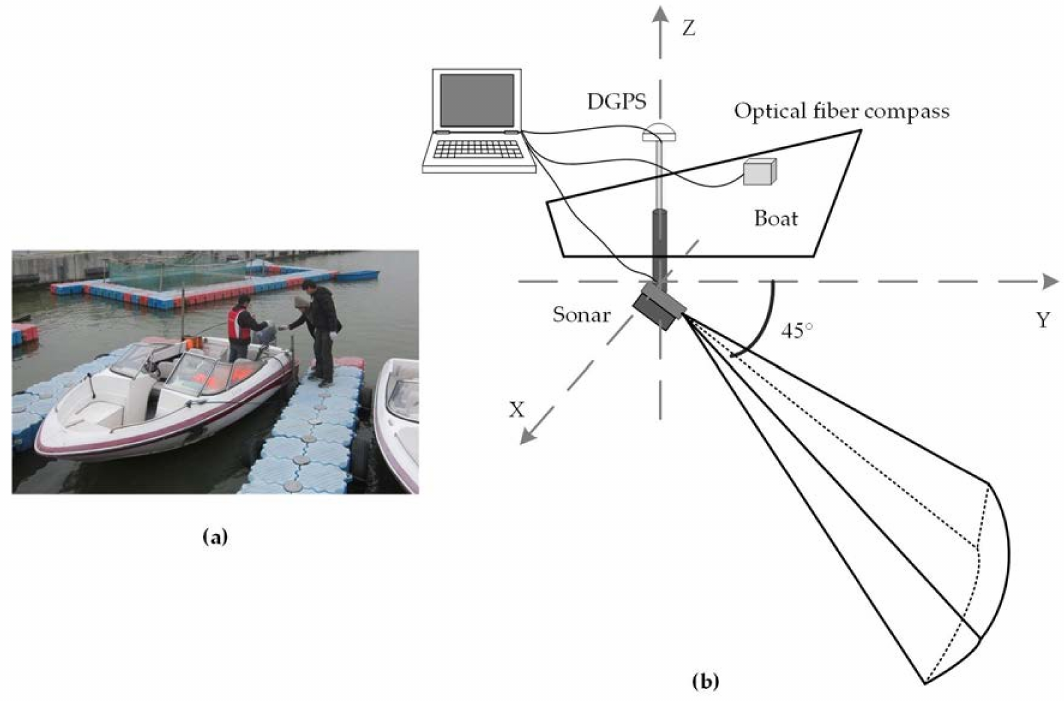
Figure 12. Sonar installation. ( a ) Measurement vessel and equipment installation in the field experiment; ( b ) diagram of the sonar